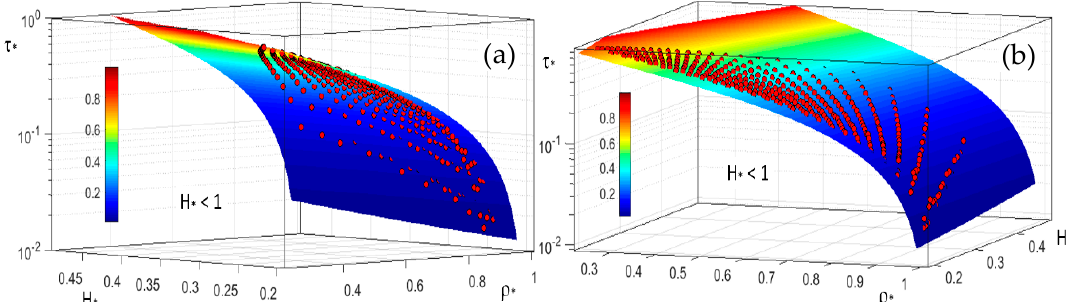
Figure 9. For H ∗ < 1, two di ff erent 3D views ( a ) from the bottom and ( b ) from the top of the stage variation–discharge relationship (Equation (29)). The experimental triplet of values ( H ∗ , ρ ∗ , and τ ∗ ) (red dots) are